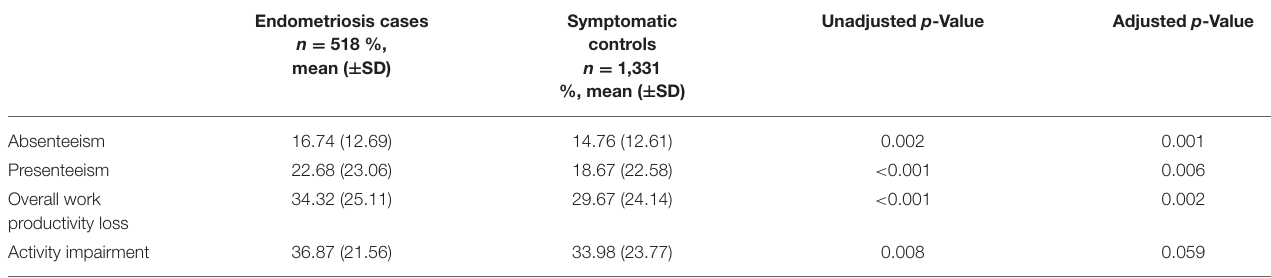
TABLE 6 | Work productivity and activity impairment in women with endometriosis and symptomatic